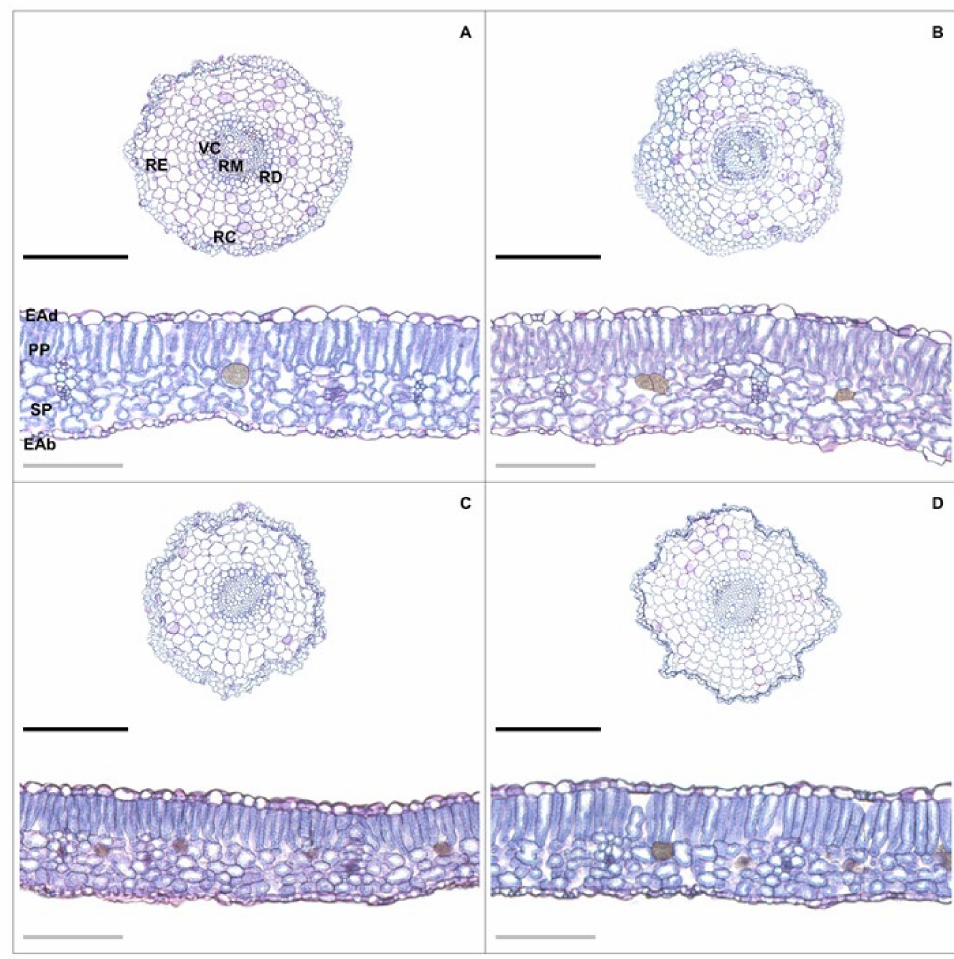
Figure 1. Root and leaf cross sections in tomato plants treated with 24-epibrassinolide (EBR) and subjected to lead (Pb) toxicity. − Pb/ − EBR ( A ), − Pb/+EBR ( B ), +Pb/ − EBR ( C ), and +Pb/+EBR ( D